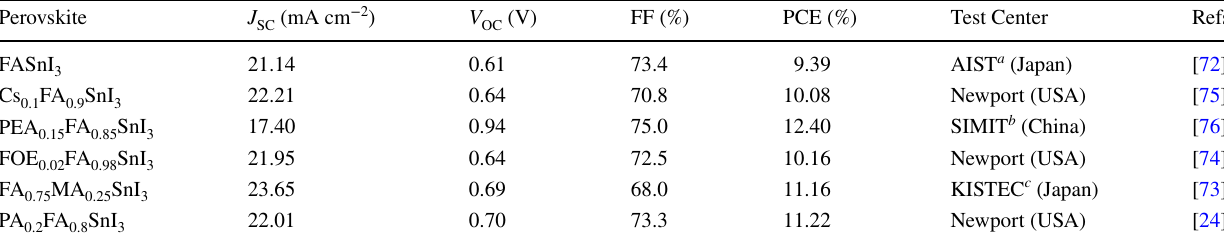
Table 1 Photovoltaic parameters of the tin PSCs reported in 2020–2021, all the device efficiencies were measured in the third-party institutes or accredited test centers TechnologyPerovskite a AIST represents National Institute of Advanced Industrial Science and Technology b SIMIT represents Shanghai Institute of Microsystem and Information Technology, Chinese Academy of Science c KISTEC represents the Kanagawa Institute of Industrial Science and